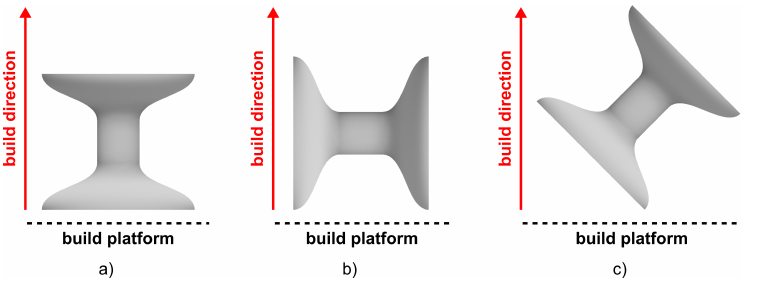
Figure 2. Orientation of the specimens during production: ( a ) vertical (0 ◦ rotation); ( b ) horizontal (90 ◦ rotation); and ( c ) tilted (45 ◦